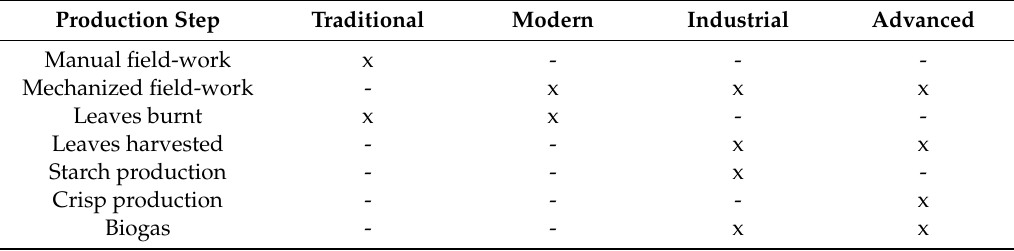
Table 3. Composition of